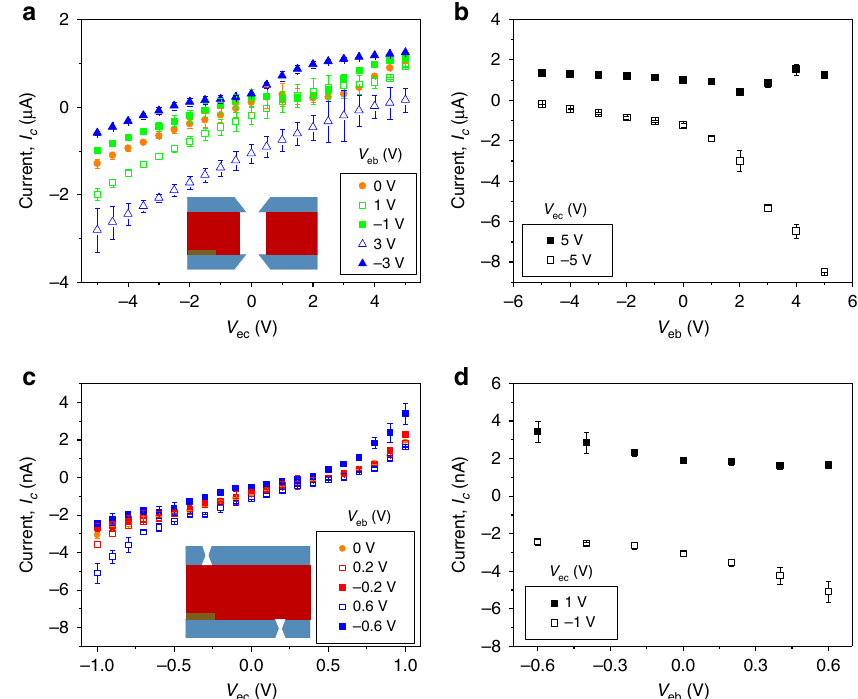
Fig. 2 Current-voltage curves of individual bipolar junctions at various base voltages. a , b Recordings for a transistor with an opening diameter of 600 nm in 10 mM KCl; ( c , d ) recordings for a device with an opening diameter of 140 nm in 100 mM KCl. b , d were created based on current-voltage curves in a and c and show I c at chosen V ec for different gate inputs. Error bars were calculated as standard deviation from an average of at least two independent voltage